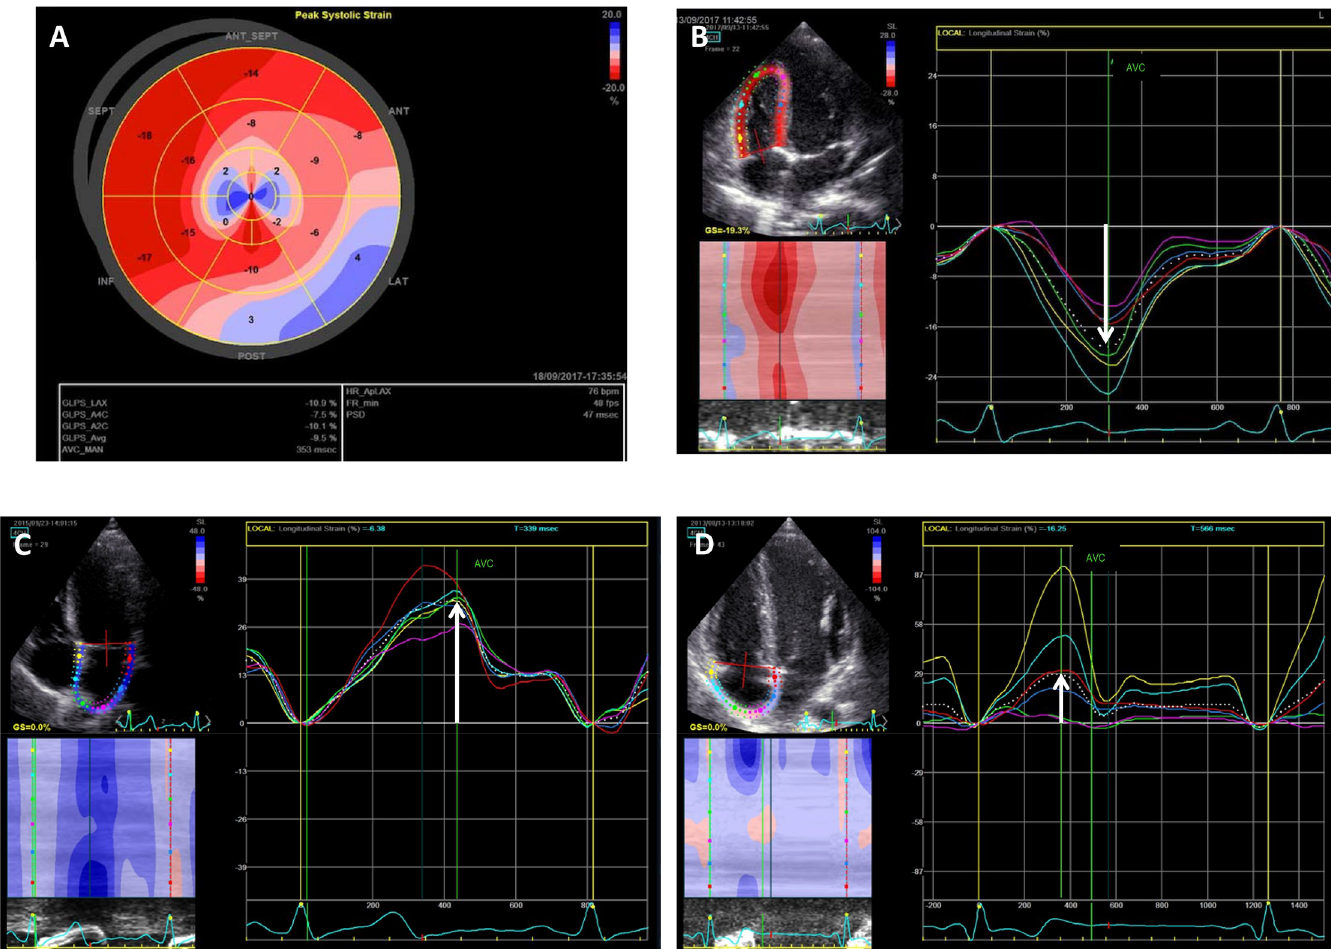
Fig 1. Follow-up 2-dimensional strain evaluation in an ALCAPA patient. (A) Impaired left ventricular global longitudinal strain (LV_GLS = -9,5%) in a patient with akinetic apical and basal postero-lateral segments (blue color); peak longitudinal strain is also calculated separately in each segment; the peak longitudinal systolic strain dispersion (PSD = 47 msec) is calculated automatically (B) right ventricular strain (-19%) (C) left atrial strain (33%) (D) right atrial strain (29%).